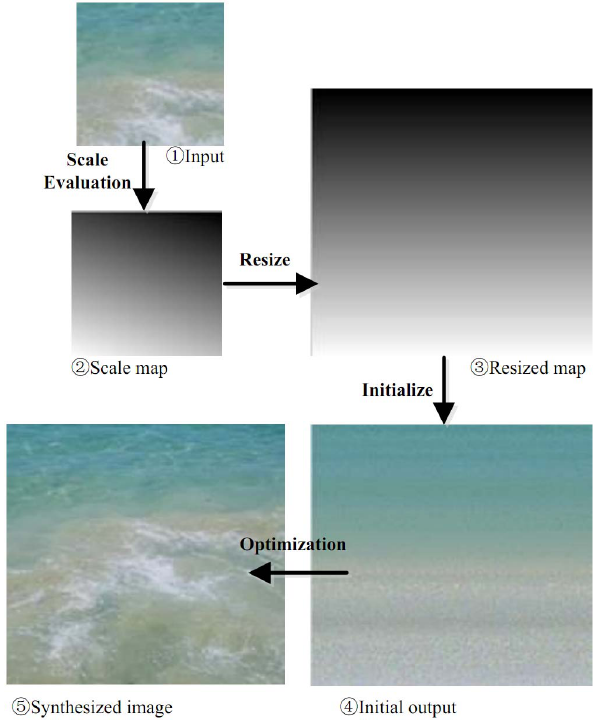
Figure 7. The flow-process diagram of our algorithm.